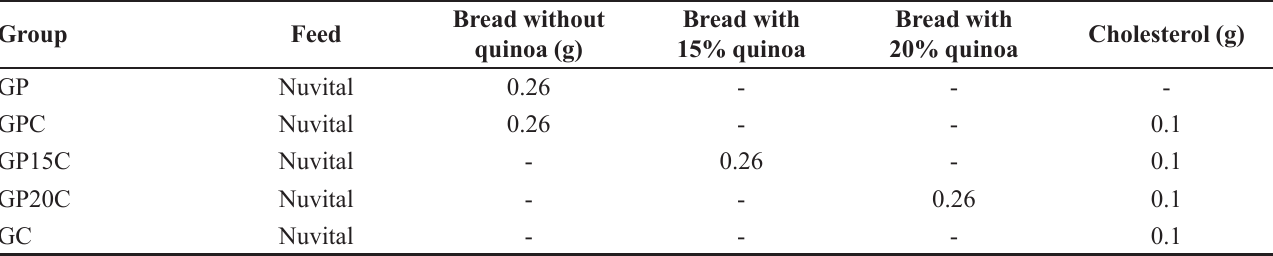
TABLE I - Groups on diet supplemented with bread (GP), bread plus cholesterol (GPC), bread with 15% quinoa plus cholesterol (GP15C), bread with 20% quinoa plus cholesterol (GP20C), and cholesterol